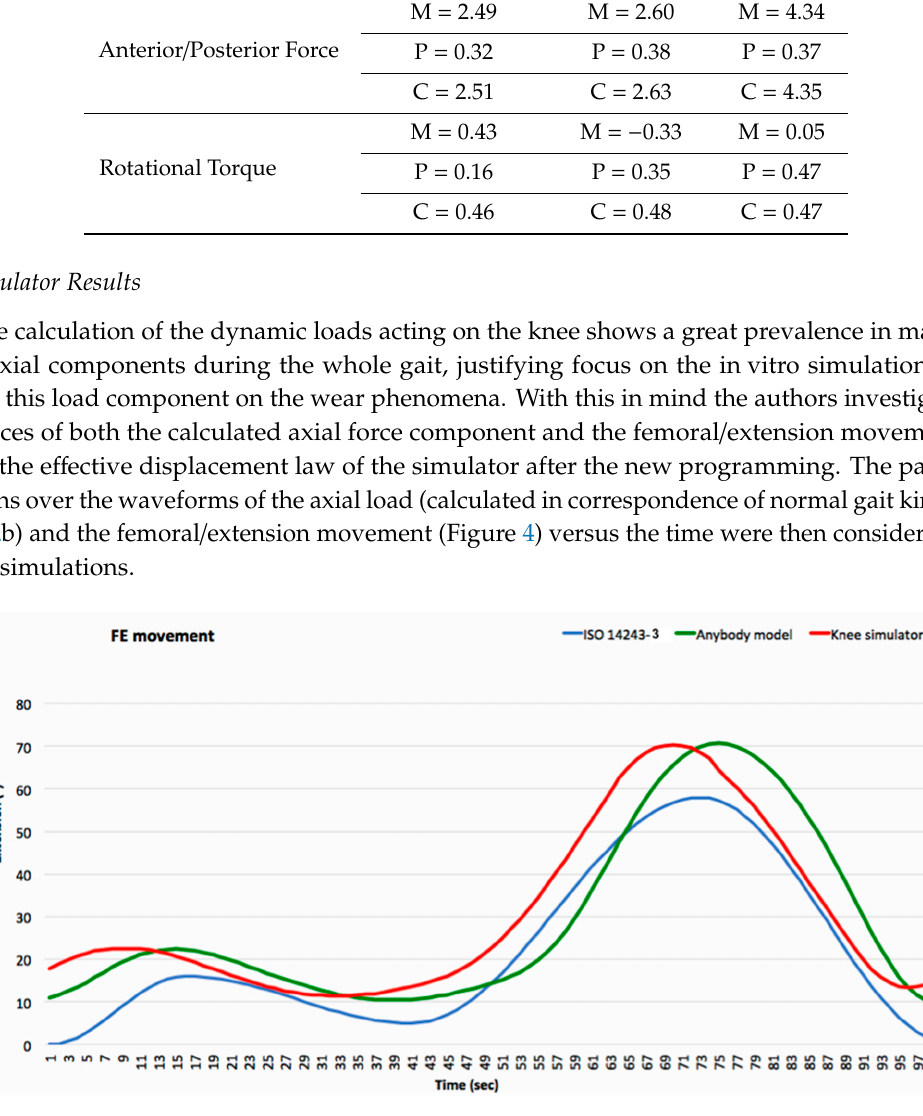
Figure 4. Representation of the femoral/extension movement of the Anybody model of the ISO standard 14243-3 and knee simulator.